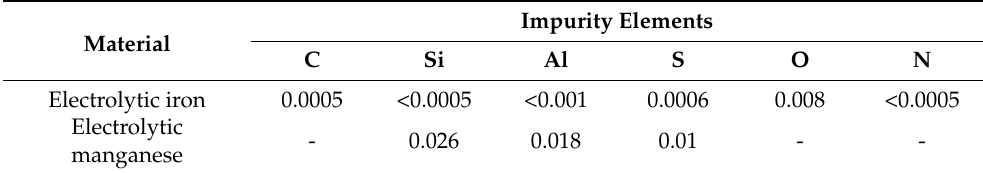
Table 1. Compositions of raw metal materials,